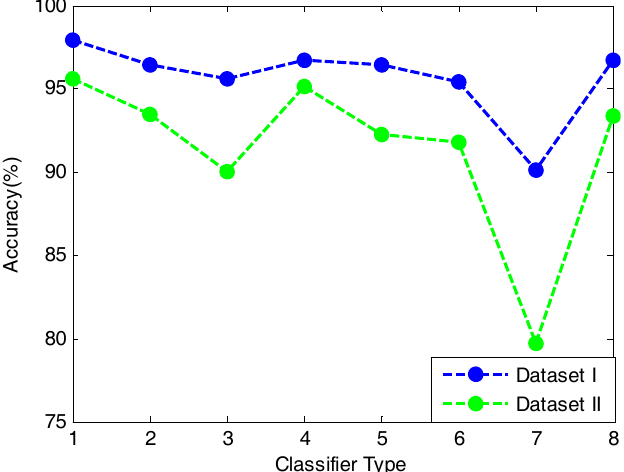
Figure 4. The overall trend of classification result among different methods of Dataset I and Dataset